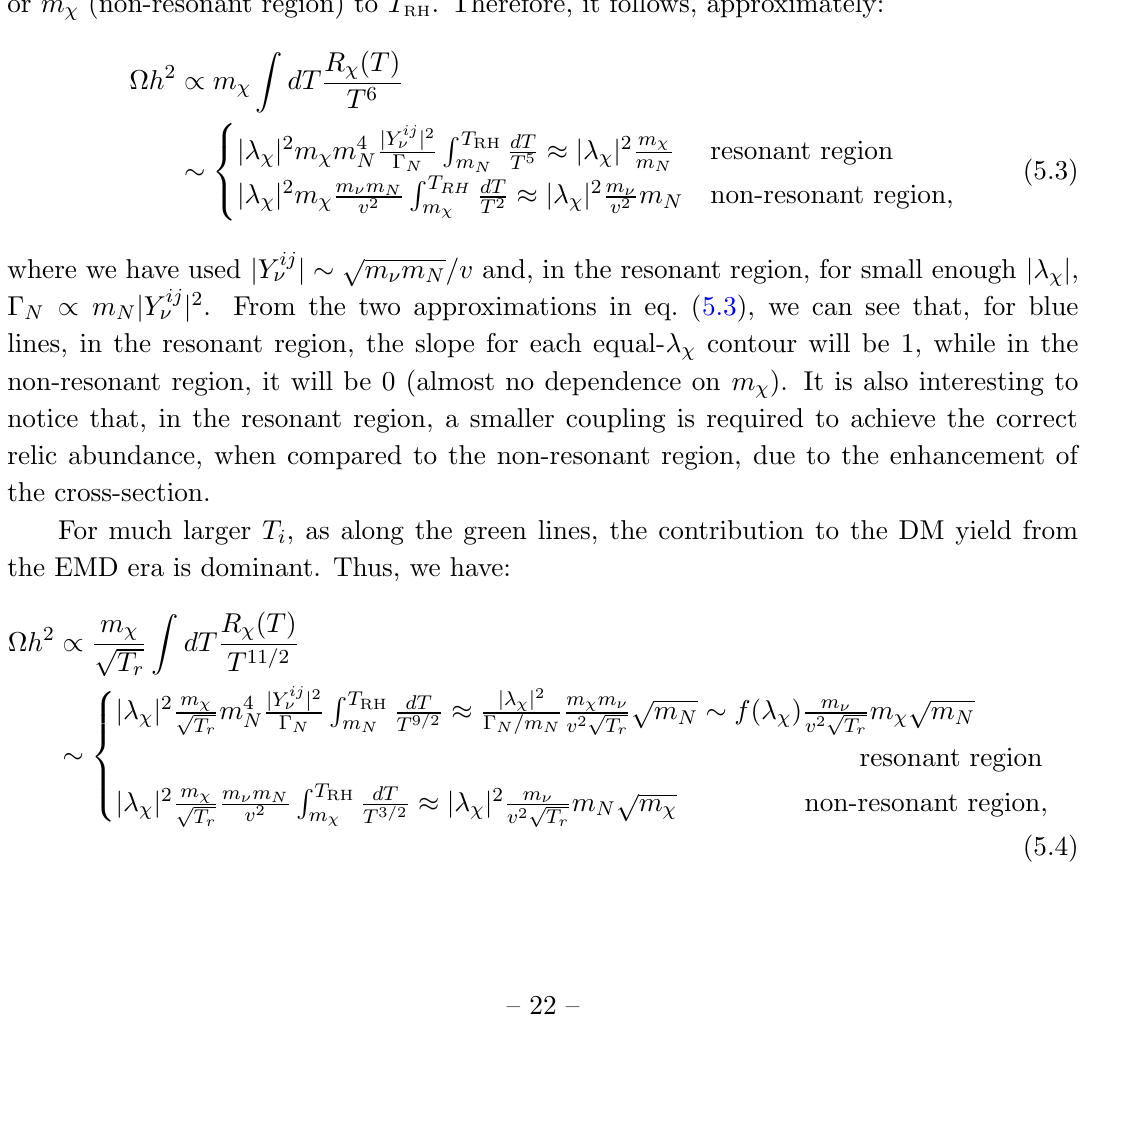
Along the blue lines, where the EMD era is short and its e(cid:11)ects will be small, the